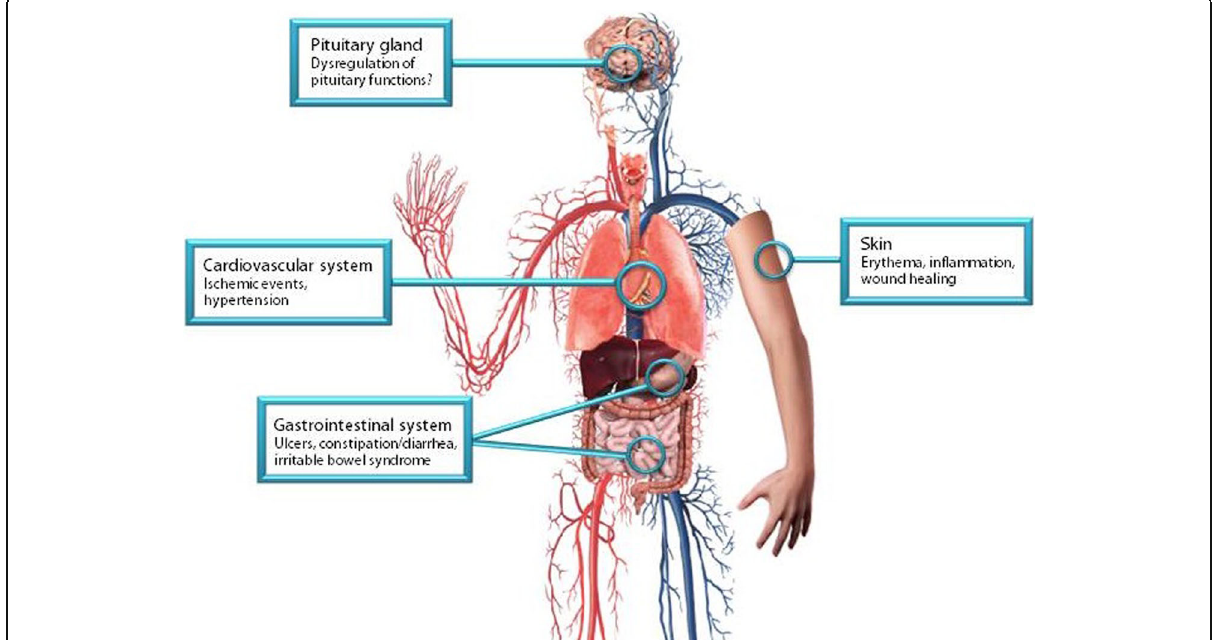
Fig. 3 Possible side effects after long-term exposure to CGRP (receptor)-antibodies. An overview of the organ systems where CGRP and the recep- tor are present and possible side effects that could be caused by the non-selective blockade of α - and β -CGRP with the CGRP